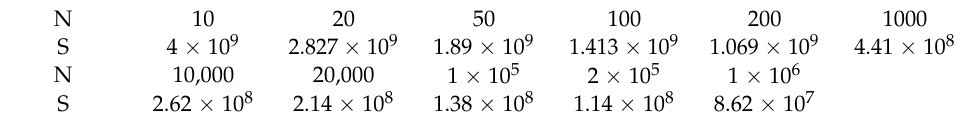
Table 2. S-N curve